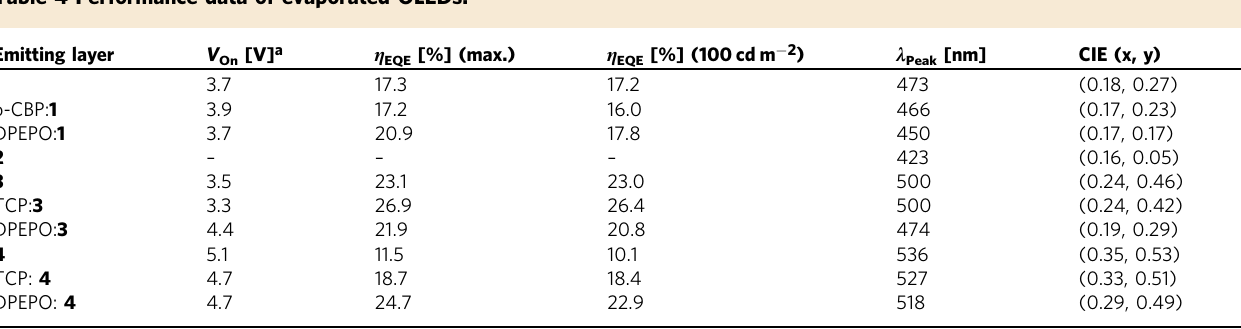
Summary of champion OLED turn-on voltage, η EQE performance and spectral parameters for varying EML composition. Metrics for 3 and TCP: 3 OLEDs reproduced from ref. 19 . a Values at brightness >1cd/m 2